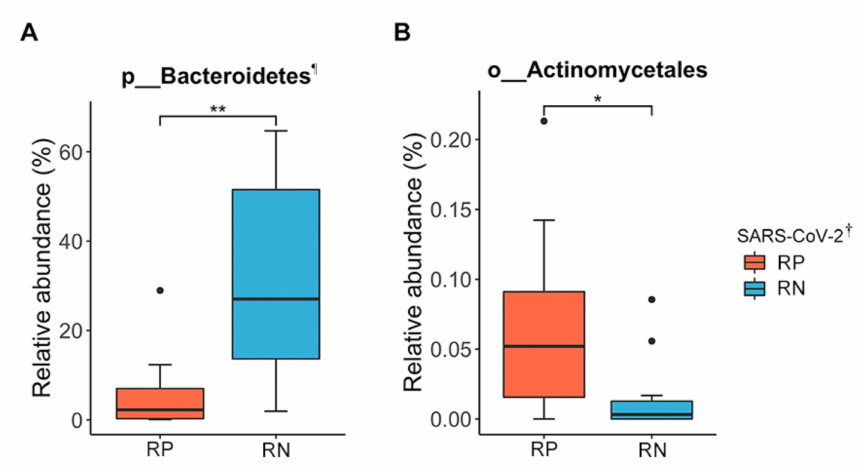
Figure 3. Significantly different taxa profiles of gut microbiota between infected (respiratory positive (RP)-SARS-CoV-2) and recovered (respiratory negative (RN)-SARS-CoV-2) states of patients with COVID-19. ( A ) The relative abundance of phylum Bacteroidetes. ¶ The phylum Bacteroidetes, class Bacteroidia, and order Bacteroidales showed the same abundance and statistically significant differences. ( B ) The relative abundance of the order Actinomycetales. The RP-SARS-CoV-2 as a baseline, the two time points as a fixed effect, and subjects’ IDs as a random effect were used in the mixed model using MaAsLin2. * FDR q < 0.05, ** FDR q < 0.01. † SARS-CoV-2 RNA from